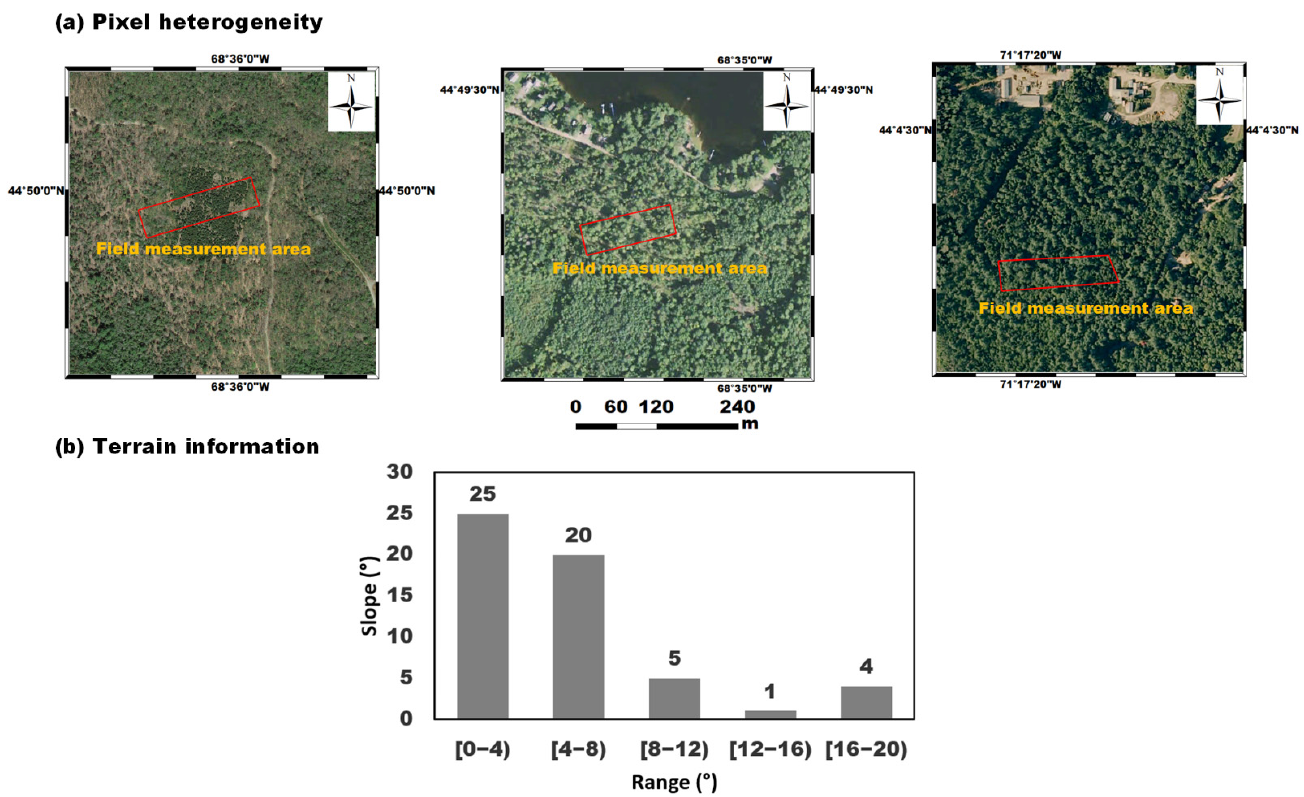
Figure 5. The landcover and topography around the observation sites; ( a ) is three typical MODIS pixel areas, and the red box indicates the field-measured area; ( b ) is the terrain slope information of all field-measured sites.